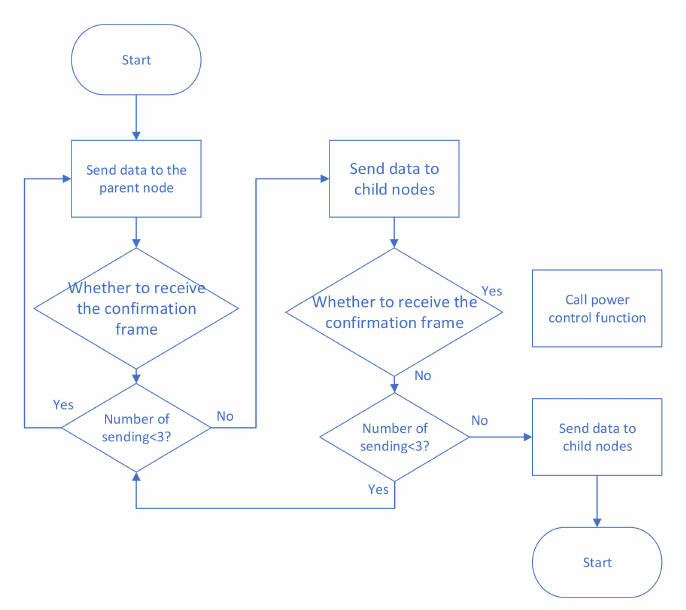
Figure 13. Schematic diagram of the disconnected network reconnection mechanism.